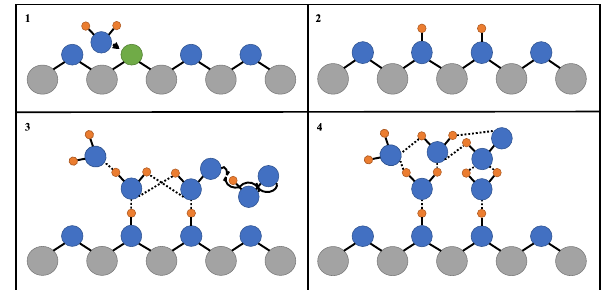
Figure 6. Simplified diagram of the important steps of HO 2 reactive uptake onto the surface of TiO 2 . Grey circles: Ti; blue circles: O; or- ange circles: H; green circles: oxygen vacancy ( V bridge ): solid black lines: chemical bond; and dashed lines: hydrogen bond. (1) Diffu- sion of water molecule towards a bridging O vacancy. (2) Resultant formation of two neighbouring bridging OH groups at the original site of the O vacancy. (3) Bridging OH groups acting as anchoring sites for water and HO 2 adsorption via hydrogen bonding, leading to multilayer water adsorption and HO 2 self-reaction via an Eley– Rideal type mechanism. (4) The build-up of a more extensive hy- drogen bonded network as more water molecules adsorb onto the particle, which stabilises HO 2 increasing its desorption lifetime and hence probability that it will